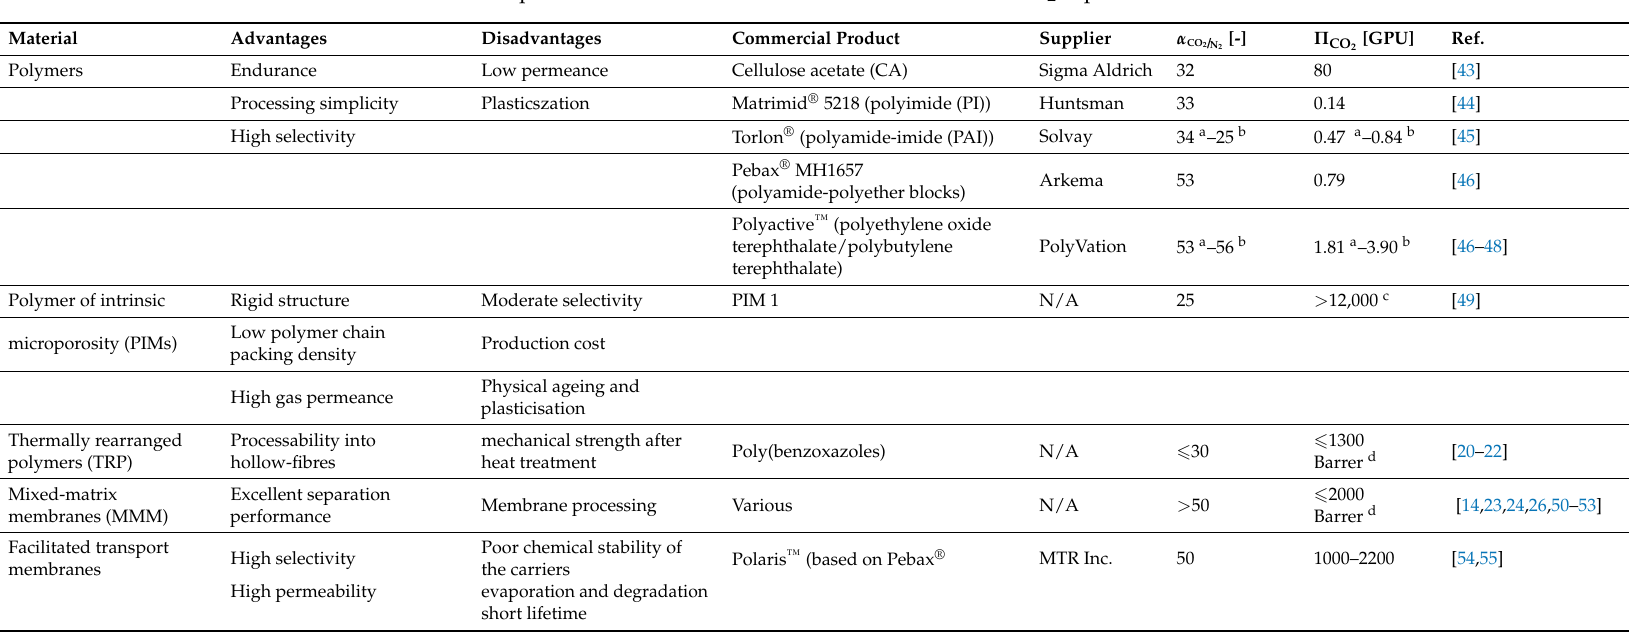
Table 1. Comparison of various materials for membrane-based CO 2 capture